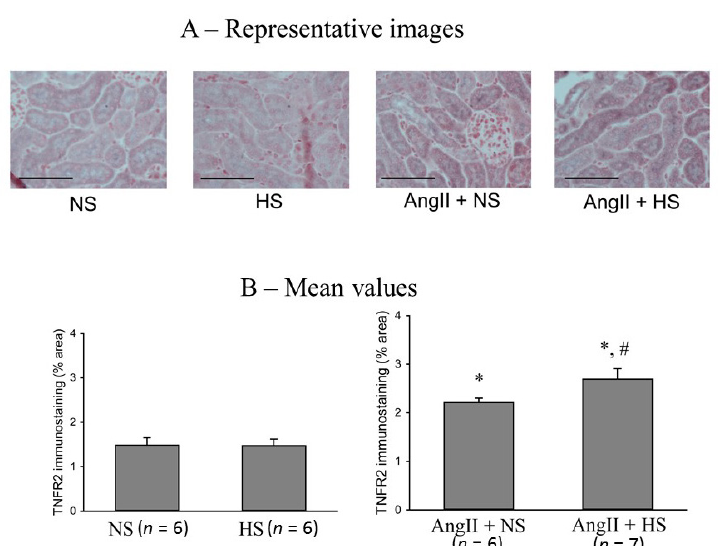
Figure 7. TNFR2 immunostainings in renal slices. (A) the representative images and (B) the mean values of percent area of positive staining for TNFR2 protein expression. The scale bar indicates 100 µm; * : P < 0.05 vs. NS; #: P < 0.05 vs. AngII + NS